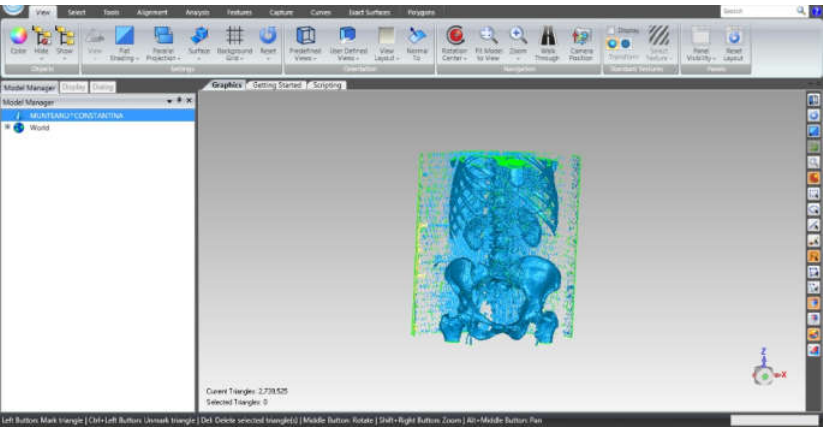
Figure 22. Geomagic software interface.